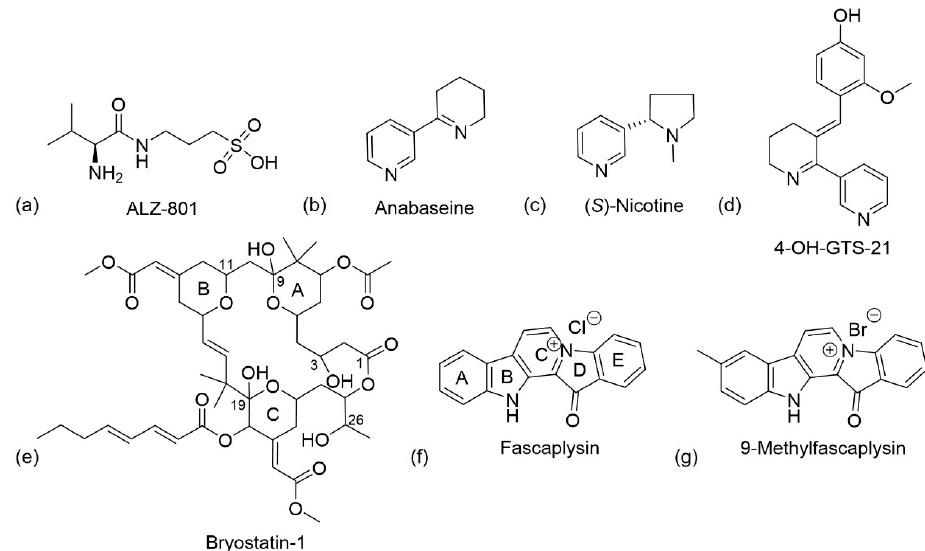
Figure 5. ( a – d , g ) Chemical structure of ALZ-801, ( S )-nicotine, anabaseine, 4-OH-GTS-21, and 9- methylfascaplysin, respectively. ( e) Chemical structure of bryostatin-1. Structure-activity relationship (SAR) studies indicated that the presence of the 20 membered macrolactone ring, C-26 free